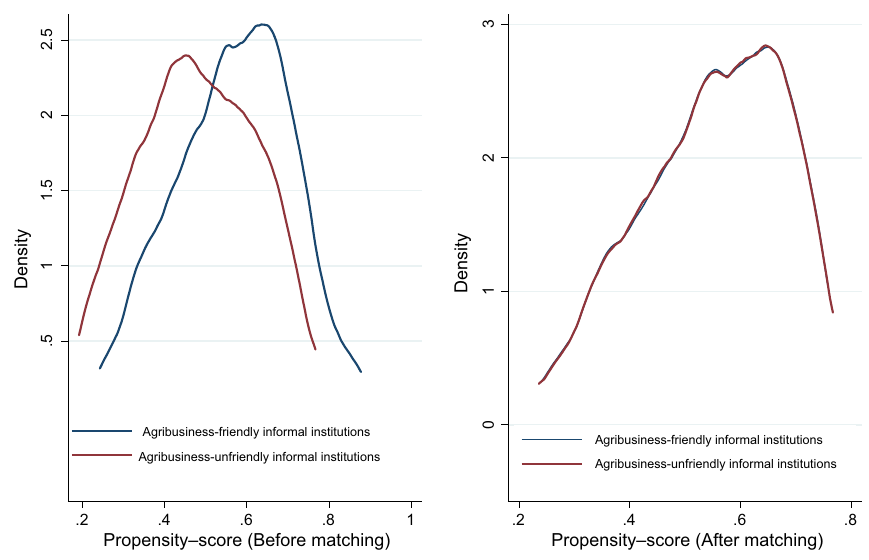
Fig. 3 Distribution of the propensity scores for the treated and the control group before and after five-to-one nearest-neighbour matching. Source : Authors, 2022